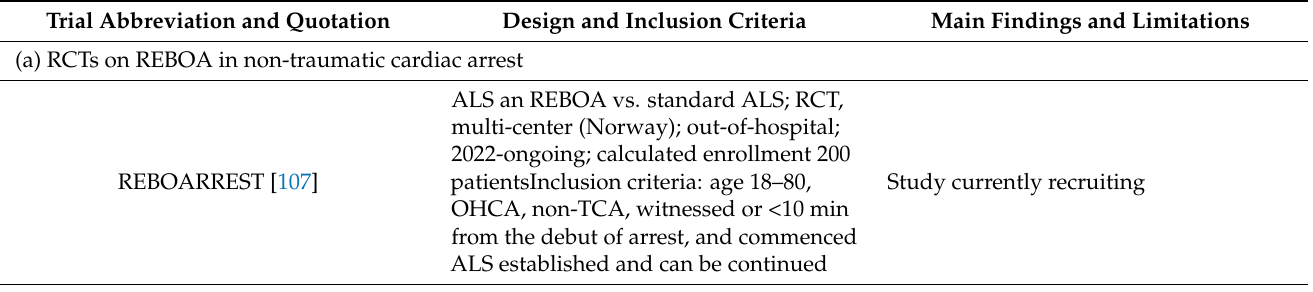
Table 4. Overview of selected studies on REBOA in